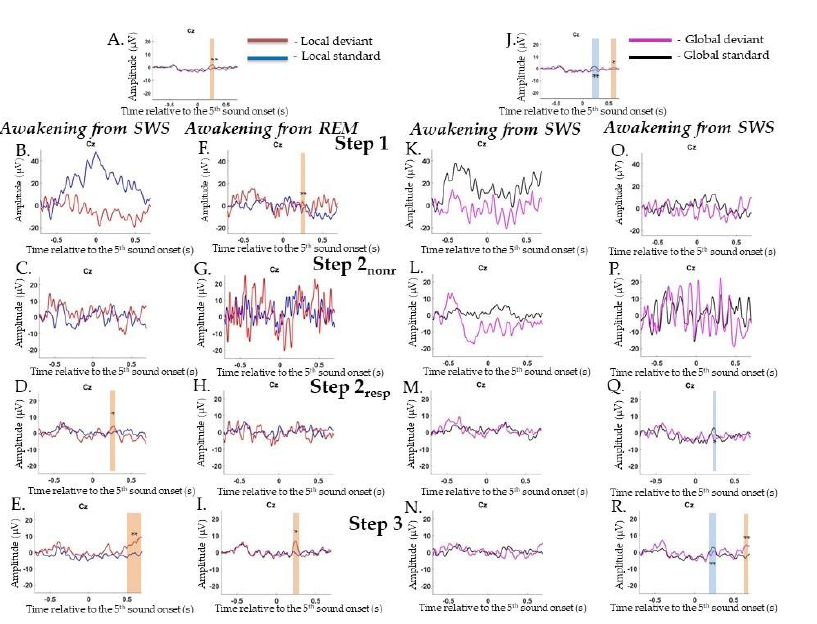
Figure A2. Event-related responses to violation of local regularity and global regularity in the sessions A2 with awakening from slow-wave sleep and rapid eye movement sleep. SWS, slow-wave sleep; REM, rapid eye movement sleep; Step 1, period of awakening when delta or theta prevail in EEG, the motor response is absent; Step 2 nonr , period of awakening when alpha prevails in EEG, the motor response is absent; Step 2 resp , period of awakening when alpha prevails in EEG, the motor response is slow; Step 3, period of awakening when alpha prevails in EEG, the motor response is accurate and timely; s, second; red line, averaged local deviants; blue line, averaged local standards; magenta line, averaged global deviants; black line, averaged global standards; No data, no data got into analysis. ( A ) Local mismatch response in EEG in Wake pre session. ( B – E ) The session with awakening from SWS for local irregularity. ( F – I ) The session with awakening from REM for local irregularity. ( J ) Global mismatch response in EEG in Wake pre session. ( K – N ) The session with awakening from SWS for global irregularity. ( O – R ) The session with awakening from REM for global irregularity. The blue-shaded region is a pool of negative clusters. The orange-shaded region is a pool of positive clusters. * p < 0.025, ** p <